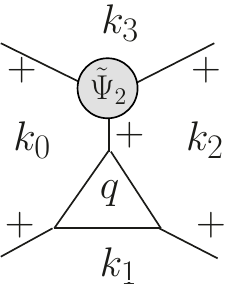
triangular one-loop diagram. q is the region momentum associated with Figure 17 . The ∆ ++++ 12 the loop and k with the external region. ˜Ψ represents the inverse Wilson line kernel eq. (3.14) i 2 expanded to second order.